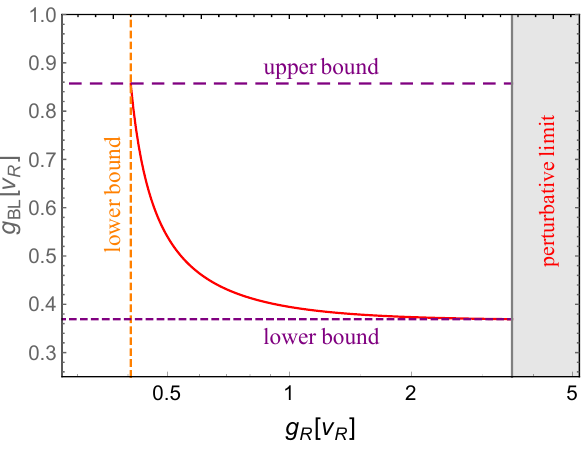
Figure 6 . Correlation of g R and g BL in the minimal LRSM at the scale v R = 10 TeV (red curve), along with the lower and upper bounds on the couplings g R;BL , induced from the requirement of perturbativity up to the GUT scale. The shaded region is excluded by the perturbativity limit p g R < 4 (cid:25)